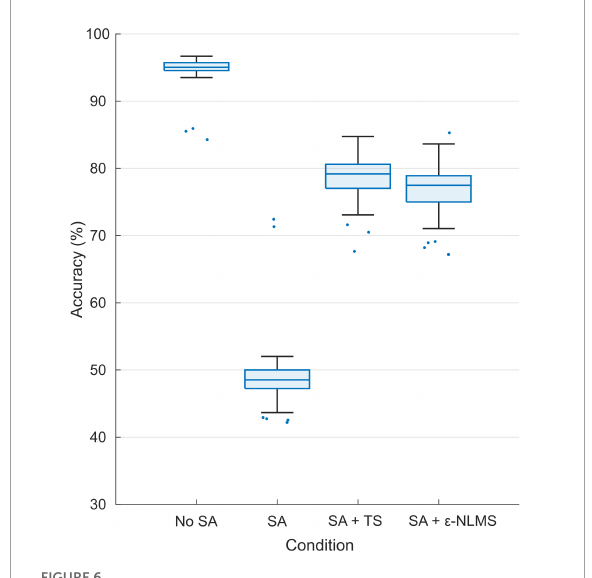
randomness of the training data split and network initialization.